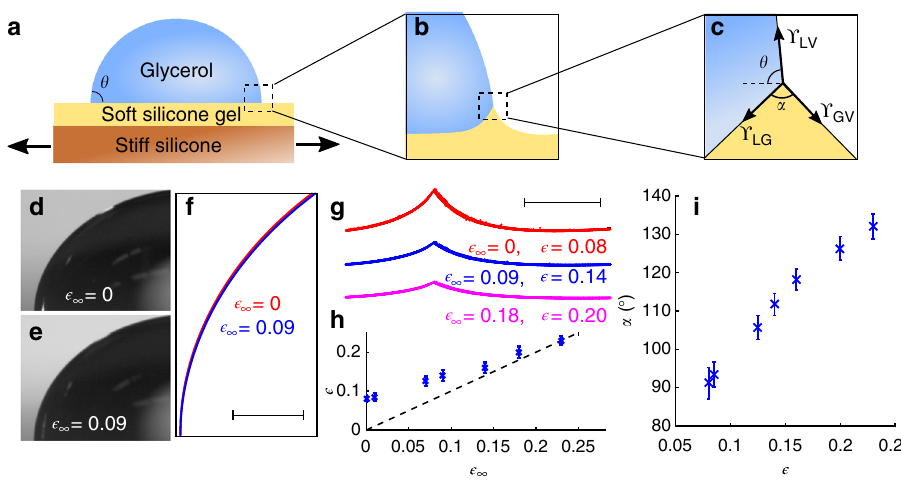
Fig. 2 Macroscopic contact angle and microscopic wetting pro fi les. a Schematic of the strain-dependent wetting experiments, using a biaxial stretcher as described in ref. 50 . b Detail of the contact line geometry at intermediate scales. c Detail of the contact line at microscopic scales, much less than ϒ / E . At this scale, the geometry of the contact line is given by a vector balance of the surface stresses as shown. d , e Macroscopic wetting pro fi les of large glycerol droplets sitting on unstretched and stretched ( ϵ 1 = 0.09) silicone gels. f Superimposed boundaries for the drops on the stretched ( blue ) and unstretched ( red ) substrates show no difference in the macroscopic contact line geometry ( scale bar : 400 μ m). g Microscopic wetting pro fi les for a single droplet on unstretched ( red ), 9% stretched ( blue ), and 18% stretched ( pink ) silicone gel substrates, respectively ( scale bar : 20 μ m). h Local strain near the contact point, ϵ , plotted against the applied strain, ϵ 1 . Dashed line has a slope of 1. i The opening angle of the wetting ridge, α , increases with the local strain, ϵ . In h , i , the error bars are SD of the population